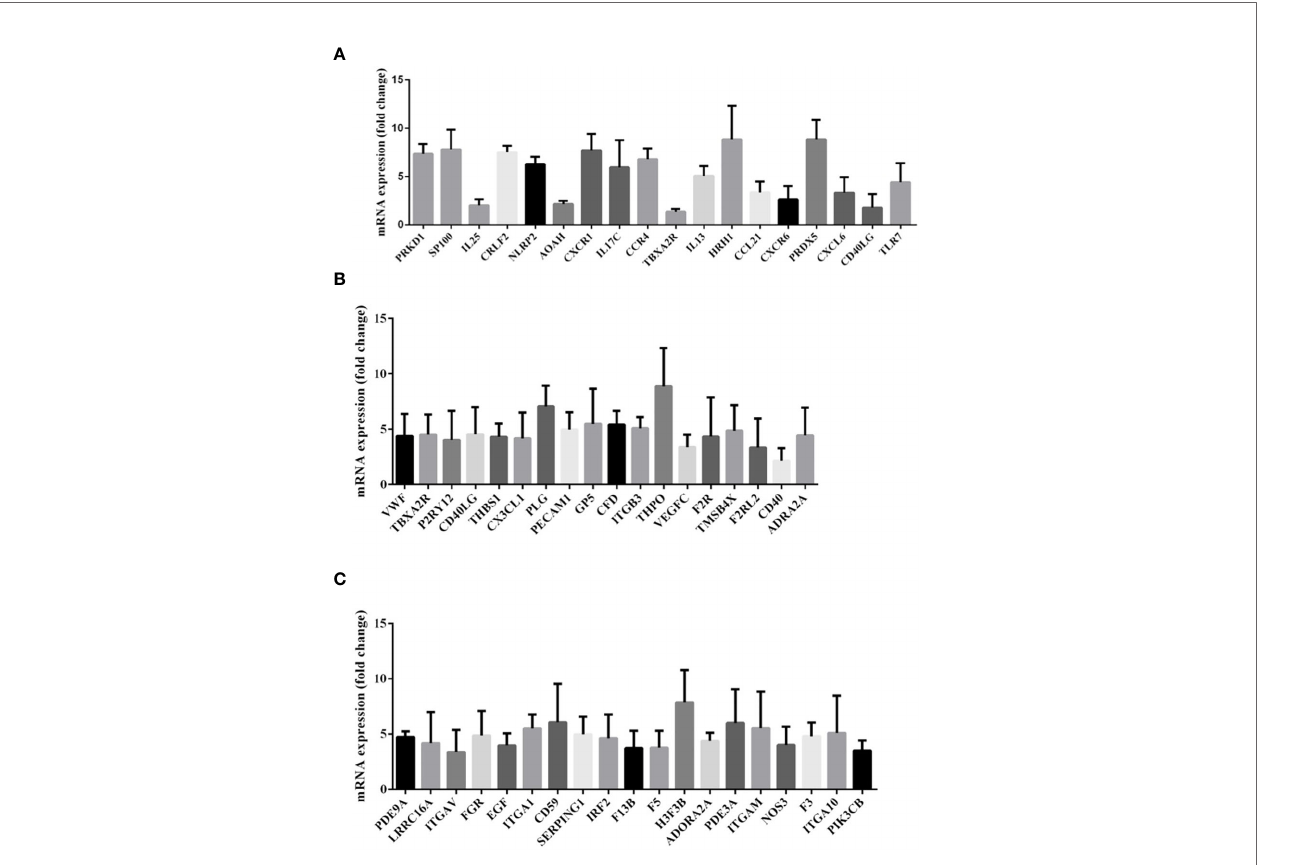
FIGURE 6 | (A) Gene expression of messenger RNA (mRNA) related to in fl ammatory response in the comparison between patients with heat stroke versus healthy control subjects. (B) Gene expression of messenger RNA (mRNA) related to platelet activation in the comparison between patients with heat stroke versus healthy control subjects. (C) Gene expression of messenger RNA (mRNA) related to blood coagulation in the comparison between patients with heat stroke versus healthy control